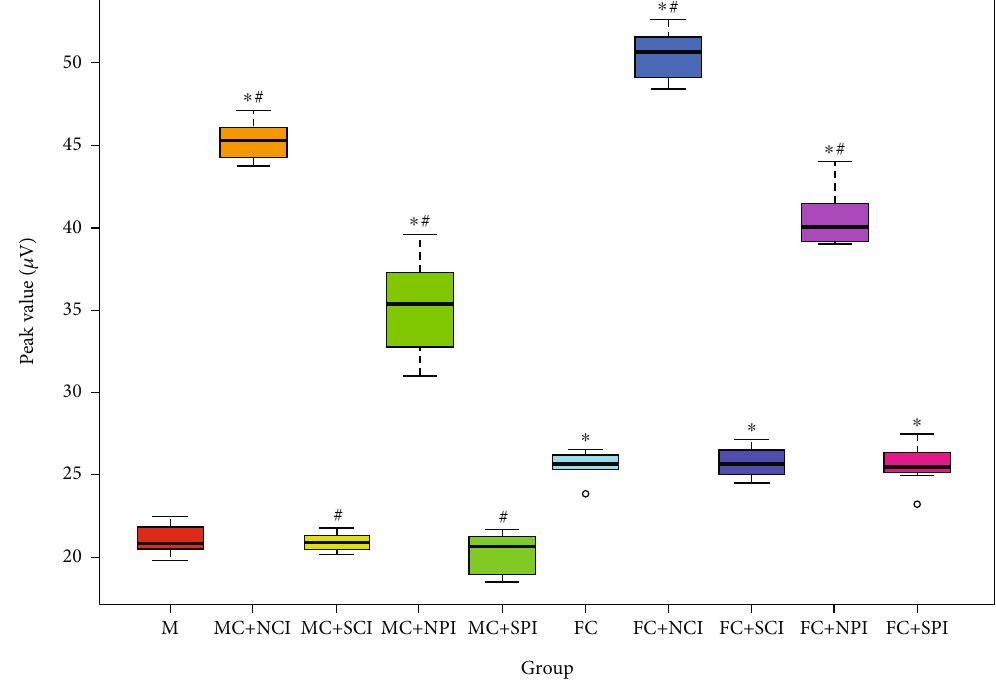
Figure 6: Comparison of abdominalwithdraw reflex ð AWR Þ = 3 points external oblique muscle electrical activity. N = 8 per group. ∗ P < 0 : 05 , compared with the MC group; # P < 0 : 05 , compared with the FC